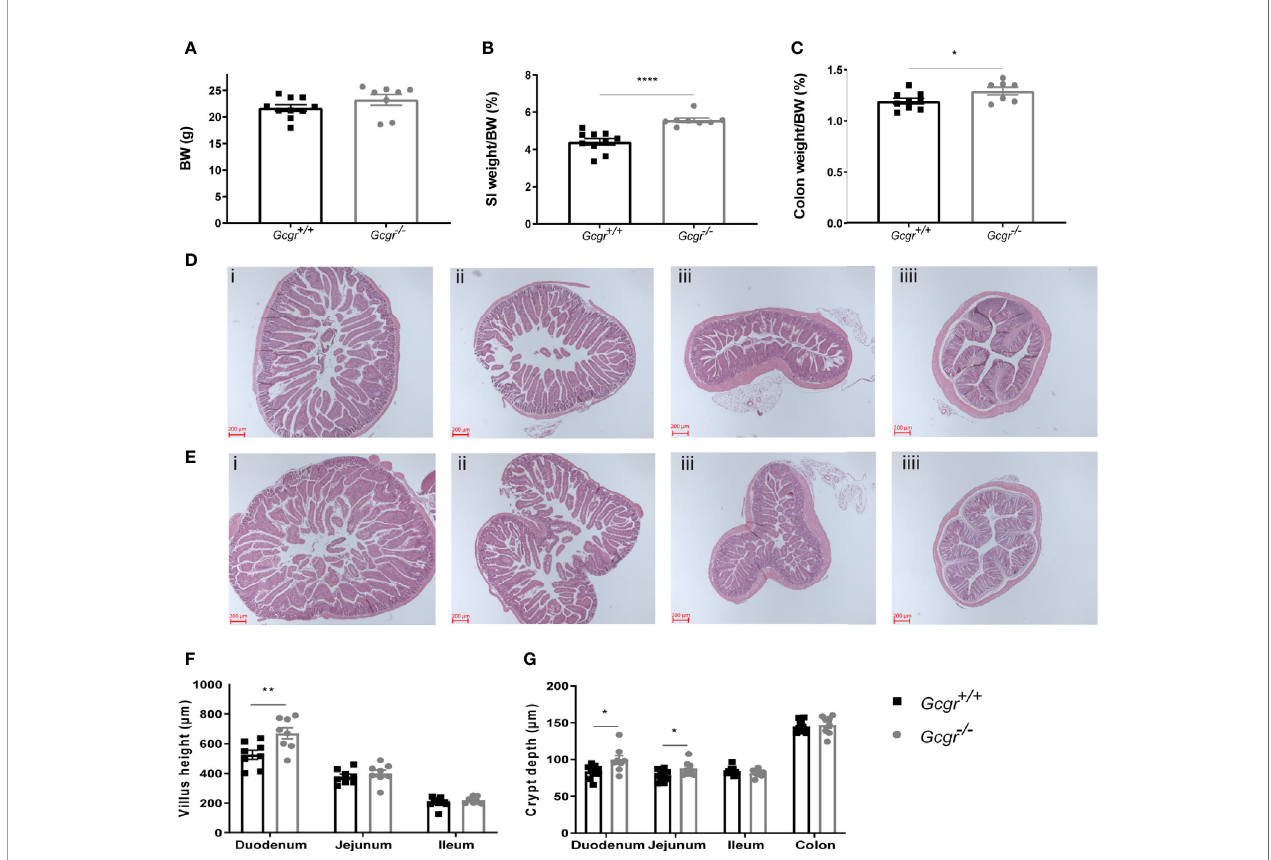
FIGURE 2 | Morphometric characterization of the intestine of Gcgr − / − and Gcgr +/+ mice. (A) Body weight (BW). (B) Small intestinal (SI) weight and (C) colon weight normalized to BW. (D) Hematoxylin and eosin-stained intestinal tissue, from Gcgr +/+ mice (Di) duodenum, (Dii) jejunum, (Diii) ileum and (Diiii) colon; and (E) Gcgr -/- mice (Ei) duodenum, (Eii) jejunum, (Eiii) ileum and (Eiiii) colon. (F) Villus height and (G) crypt depth estimations. Data were compared using a two-sided, unpaired students t-test and presented as means ± SEM. *p value <0.05, **p value <0.01, ****p value